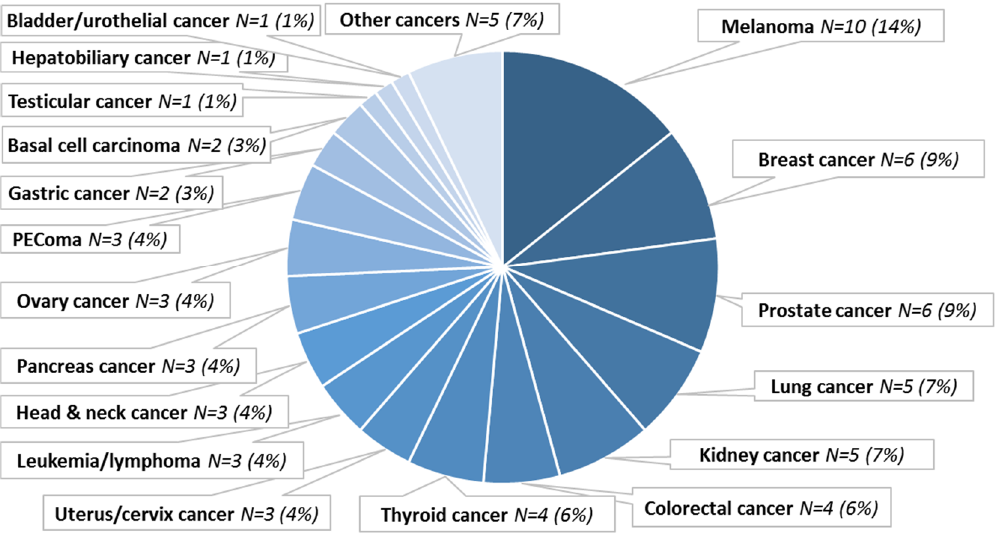
Figure 1. Cancer type distribution. Seventy patients with exceptional responses were curated. Abbreviations: N = number; PEComa = perivascular epithelioid cell tumor.